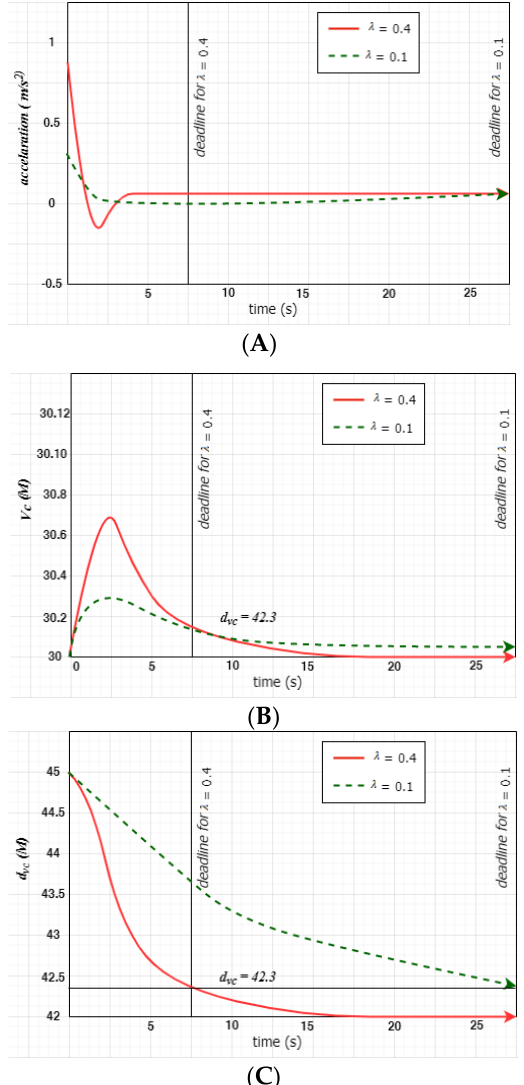
Figure 8. ( A ) Acceleration; ( B ) Velocity; ( C ) Following distance.